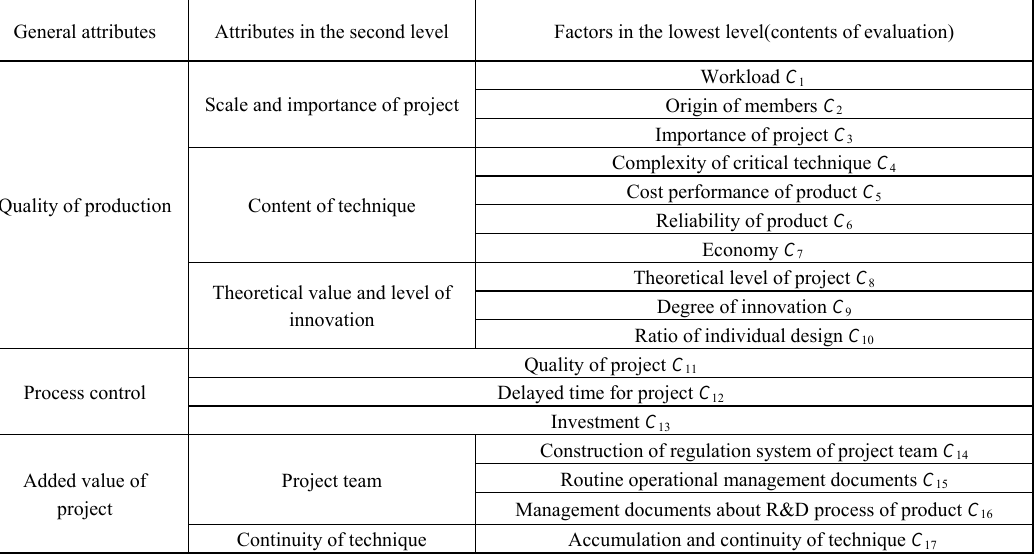
Table 1. The standard table for checkout and evaluation system of strategic R&D